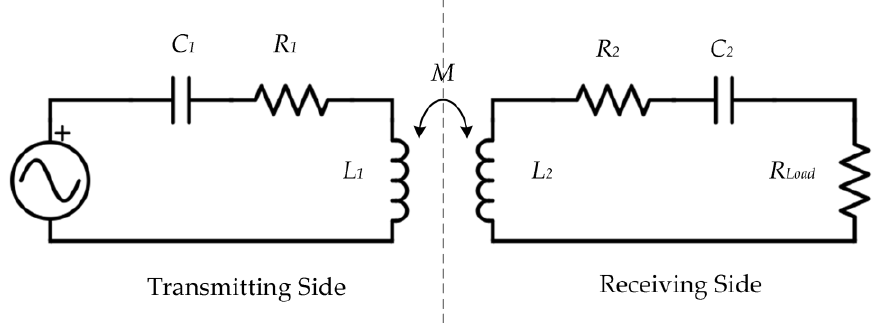
Figure 1. Basic series–series topology of WPT system.